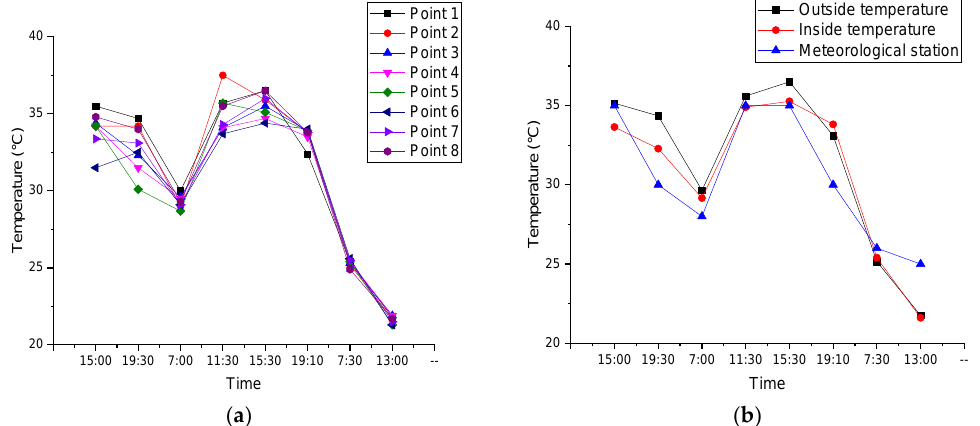
Figure 5. Measurement of dry-bulb temperature: ( a ) variation of dry-bulb temperatures with time; ( b ) comparison of dry-bulb temperatures inside and outside the street.